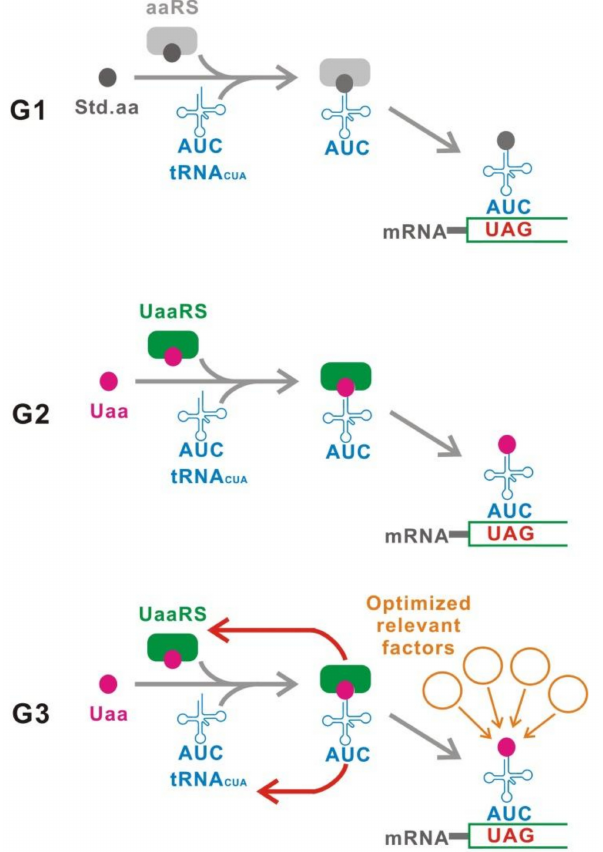
Figure 2. Classification. The first generation (G1) uses a tRNA CUA carrying a standard natural amino acid. In contrast, an unnatural aminoacyl-tRNA synthetase/tRNA CUA pair suppresses UAGs in the second generation (G2). The third generation (G3) is an upgraded G2 that achieves the best performance for switching. Figure 4 illustrates G3 in detail. Std.aa, a standard amino acid. Uaa, an unnatural amino acid. UaaRS, unnatural aminoacyl-tRNA